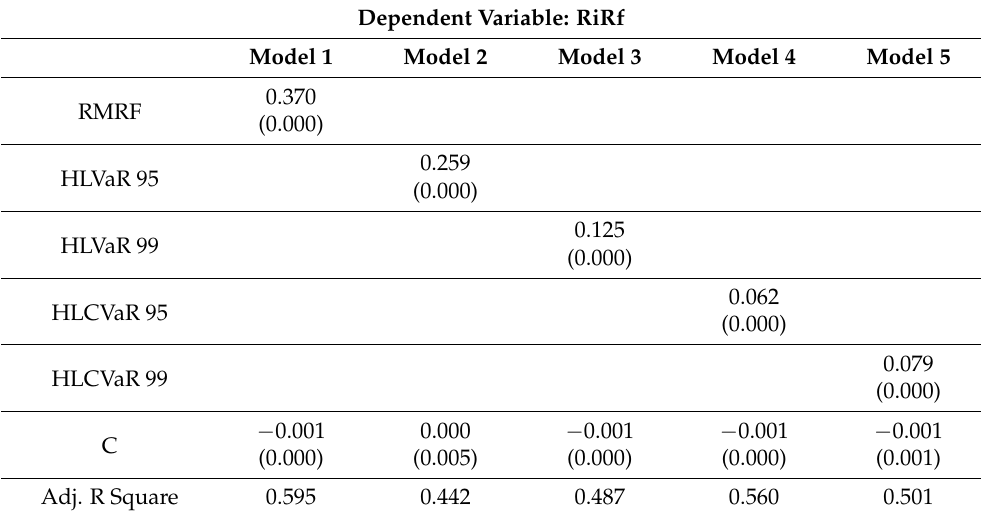
Table 6. Single factor systematic risk controlling models. The table represents five models with the dependent variable of excess returns of manufacturing companies (RiRf) listed on the Pakistan Stock Exchange from 2002 to 2014. Independent variables include all systematic risk factors which the study proposed. Excess market returns (Rm-Rf) are calculated from the subtraction of KSE 100 Index returns from the risk-free rate of returns. HLVaR is the subtraction of average returns of High VaR portfolio returns from Low VaR portfolio returns. VaR is observed at both 95% and 99% level of significance. HLCVaR represents subtraction of high ES return stocks from low ES returns stocks. The probability value is provided below, describing the coefficient effect dependent variable’s